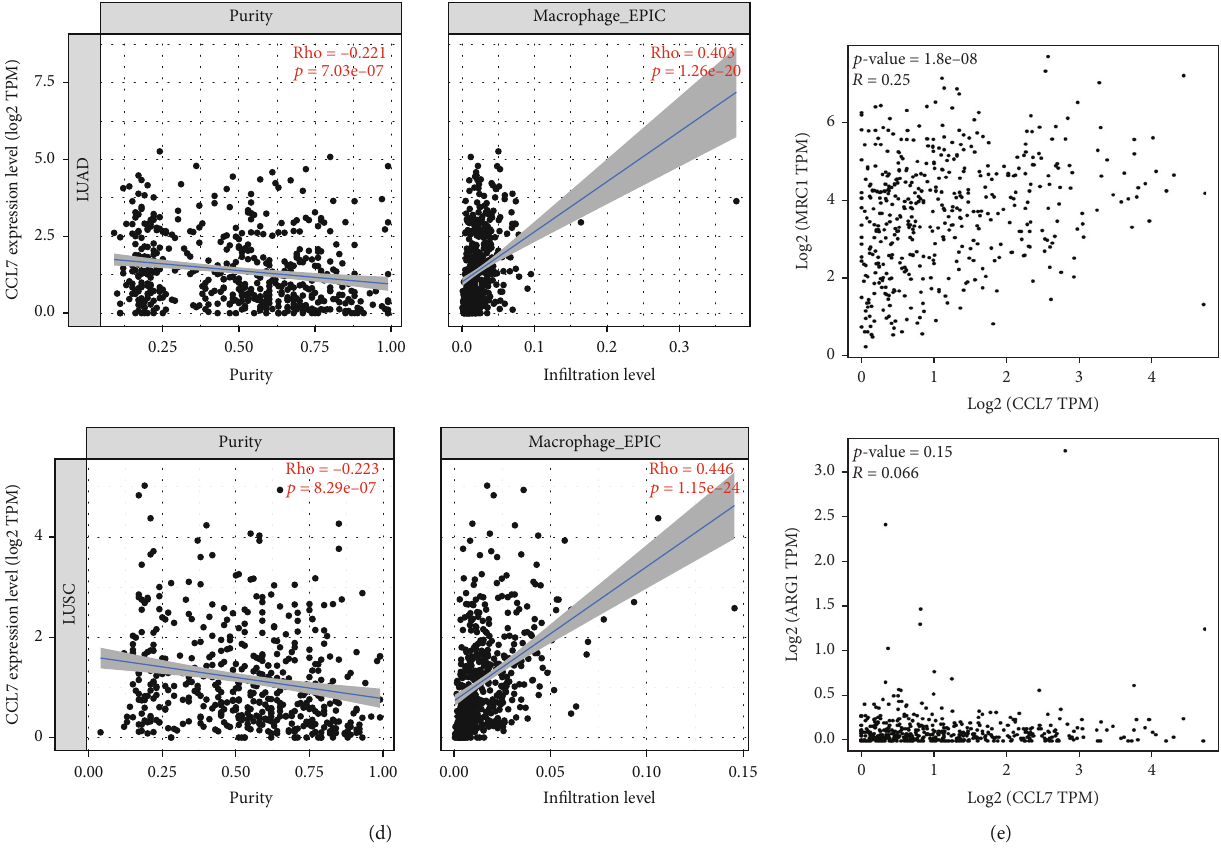
Figure 1: CCL7 is highly expressed in LUAD and linked to increased TAM in fi ltration. (a) CCL7 expression in LUAD and normal lung tissues in the Oncomine database; (b) CCL7 expression in TCGA-LUAD database of tumor tissues and in GTex database of normal lung tissues; (c) correlation between CCL7 expression and patient ’ s prognosis; (d) correlation of CCL7 expression with the immune cell in fi ltration in LUAD patients; (e) correlations of CCL7 expression with the M2 macrophage markers ARG1 and